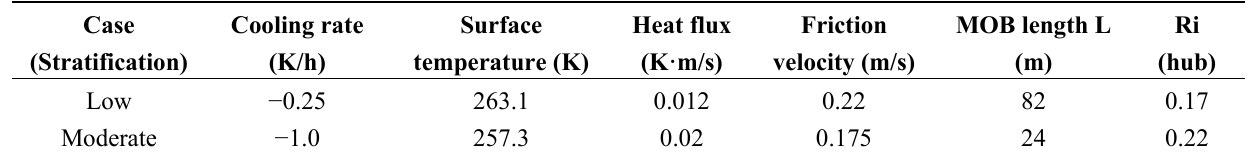
Table 2. ABL parameters cooling rate, surface temperature, heat flux, friction velocity, Monin-Obhukov (MOB) length (L) and Richardson number at hub height for low and moderate stratified